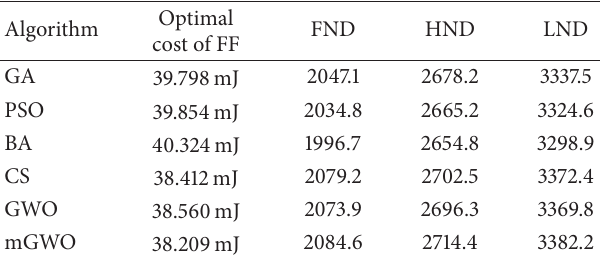
Table 9: Comparison results of CH selection problem in